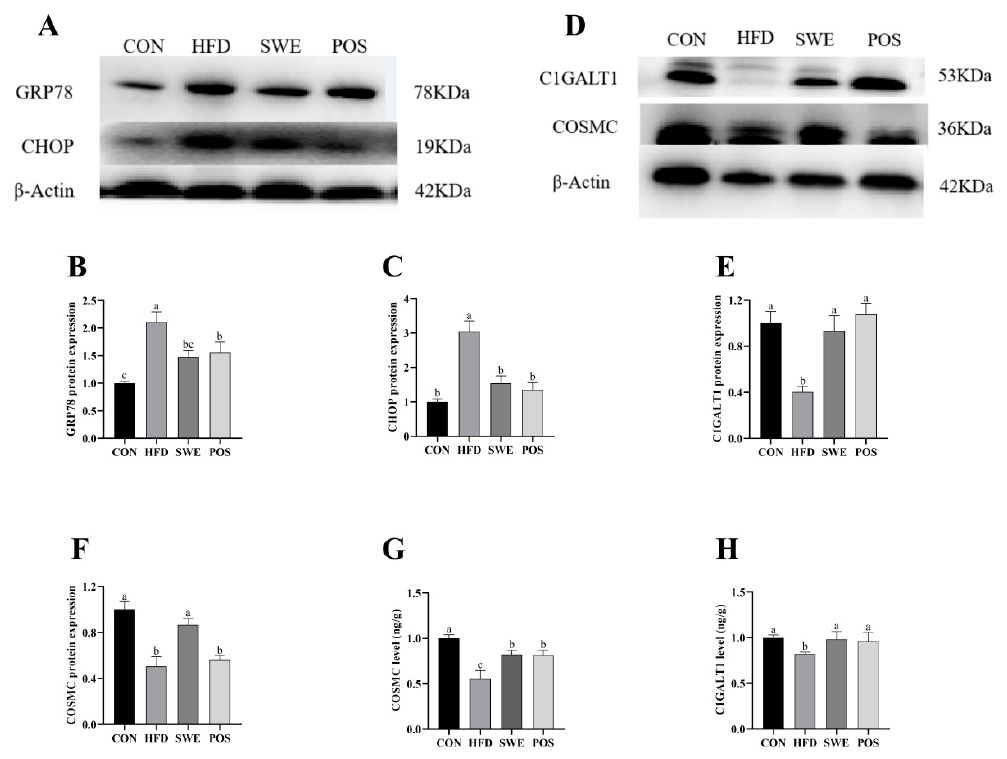
Figure 5. Effects of SWE on colonic ER stress markers and mucin O-glycosylation in the colon. Western blot analysis: ( A ) protein abundance of GRP78 and CHOP, ( B ) GRP78 protein expression, ( C ) CHOP protein expression, ( D ) protein abundance of C1GALT1 and Cosmc, ( E ) C1GALT1 protein expression. ( F ) Cosmc protein expression. ELISA analysis: ( G ) C1GALT1 level in colon tissue, ( H ) Cosmc level in colon tissue. Values are expressed as mean ± S.E.M. Different letters indicate significant differences ( p < 0.05). n = 4–8 per group.